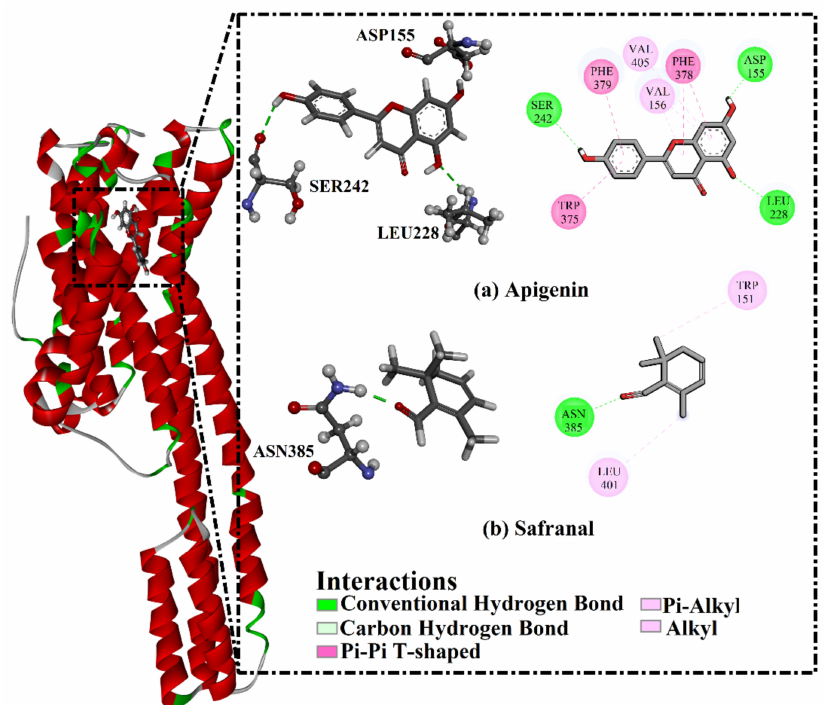
Figure 3. The predicted binding modes of ( a ) apigenin and ( b ) safranal with the 5HT2AR, in accordance with the last trajectory of the 200 ns MD